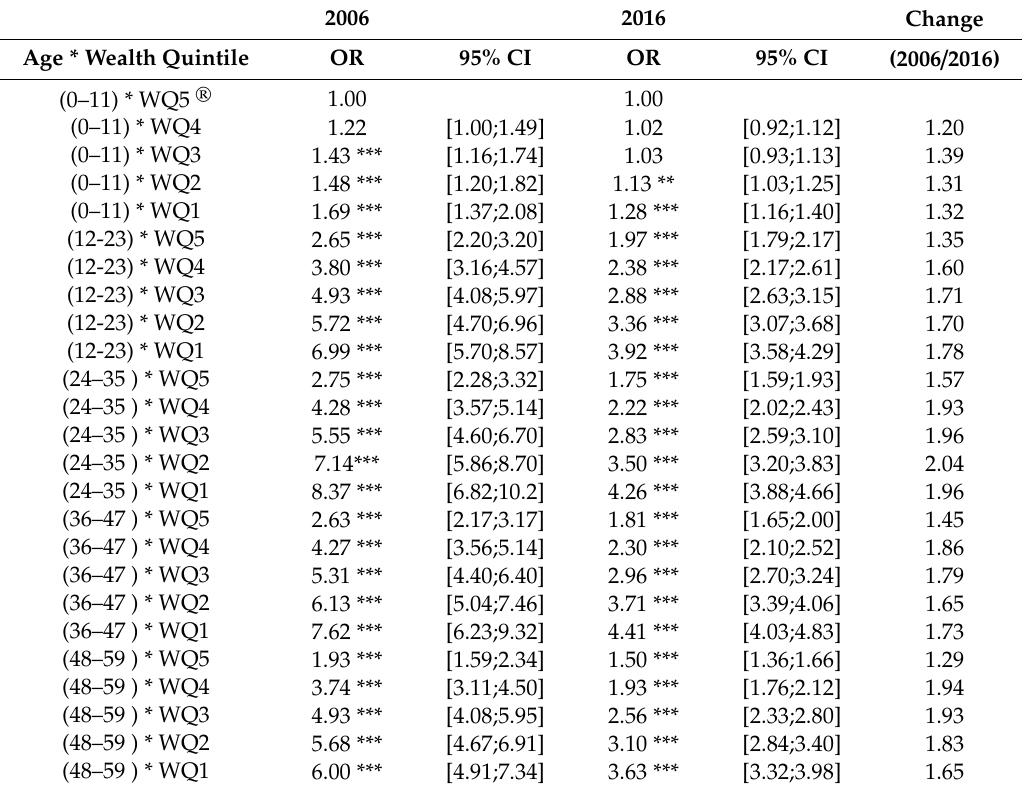
Table 4. Multilevel logistic regression-based odds ratio of child stunting across age groups (in months) and wealth quintiles, NFHS 2006 and